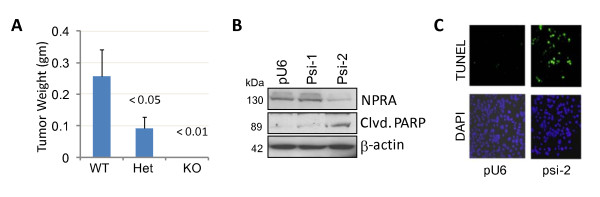
NPRA-deficiency impairs tumor engraftment and induces apoptosis of PCa cells. (A) NPRA-deficiency impaired engraftment of TRAMP-C1 cells. Three groups of mice (wild type (WT), heterozygous (Het) and homozygous (NPRA-KO), (n = 5 per group) were injected s. c. in the left and right flanks with 5 × 106 TRAMP-C1 cells per site. Mice were euthanized ten weeks after injection. Tumors were excised and weighed. Mean tumor weights ± SEM are shown. (B-C) NPRA deficiency induced apoptosis of PCa cells. TRAMP-C1 cells were transiently transfected with psiNPRA (si1 and si2) and control plasmid (pU6). Cells were harvested 72 hrs later and whole cell lysates were analysed for NPRA and PARP by western blotting. (C) TRAMP-C1 cells were transfected with pU6 or psi2 plasmids. Forty-eight hours after transfection, apoptosis was monitored by TUNEL assay.